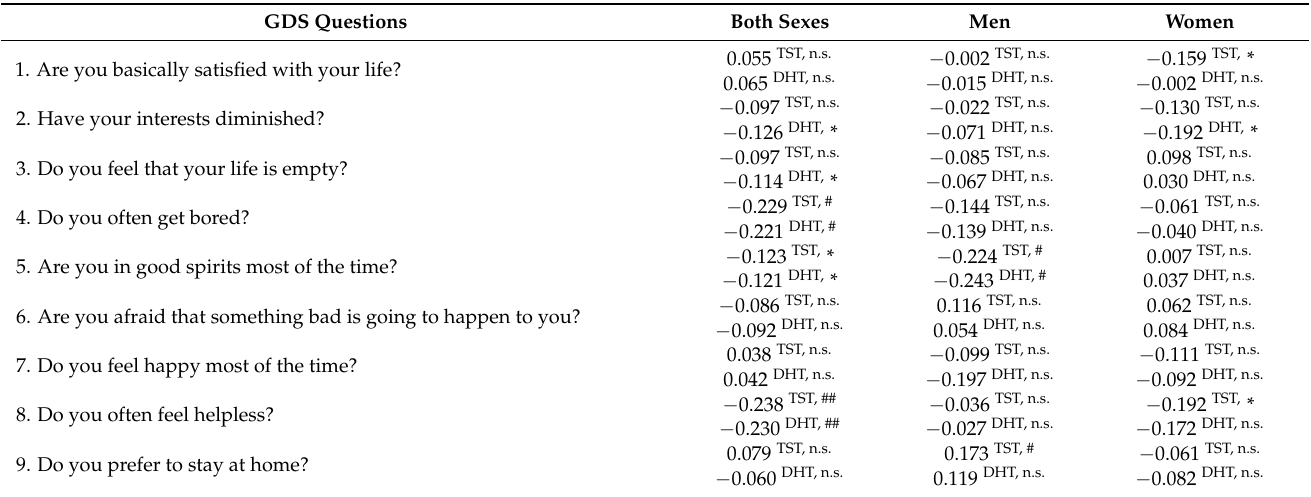
Table 4. Associations between plasma testosterone and dihydrotestosterone levels and GDS scores (total score and according to individual questions indicating potential